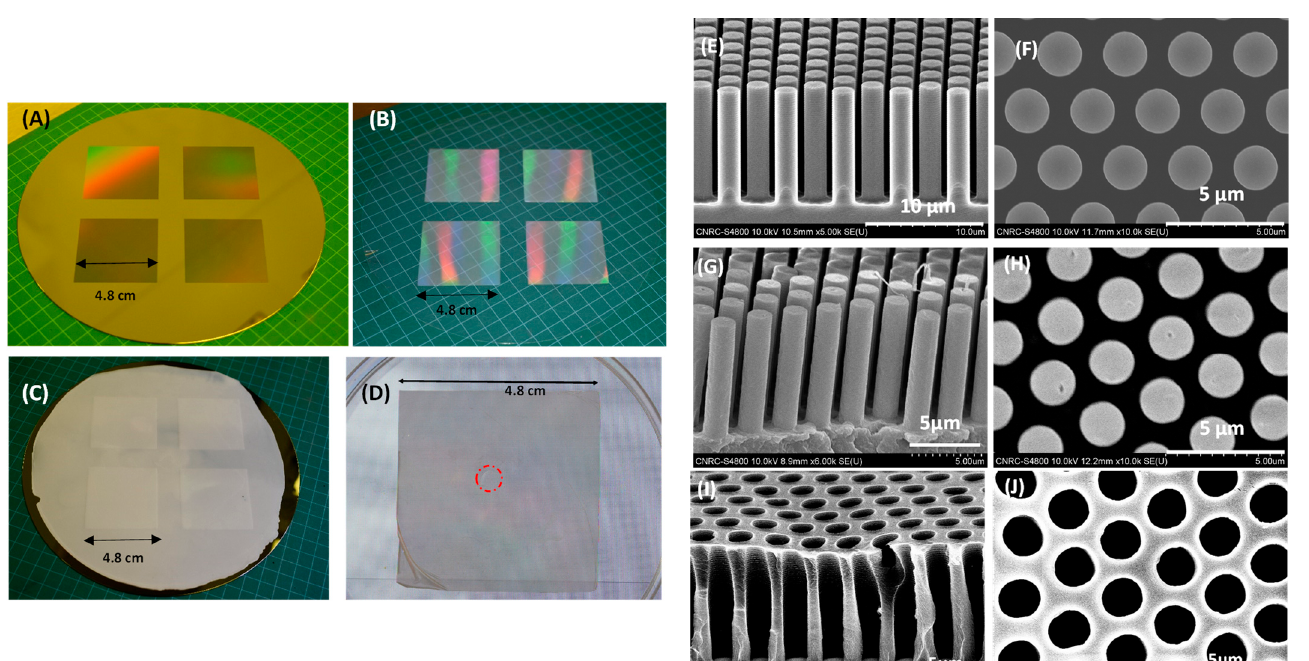
Figure 4. ( A ) Si master mold; ( B ) Intermediate FEP mold replicated from the Si master mold shown in ( A ); ( C ) Photo of a PLA template mold replicated from the FEP mold using HE; ( D ) A section of MD700 membrane (4.8 cm by 4.8 cm) area marked by a dotted red circle (defects) where the holes of the MD700 membrane are not open through. ( E ) SEM image of a Si master mold (tilt view); ( F ) SEM image of a Si master mold (top view); ( G ) SEM image of a sample cut from the PLA template mold (tilt view); ( H ) SEM image of a sample cut from the PLA template mold (top view); ( I ) SEM image of a piece of MD700 membrane replicated from the PLA template mold (tilt view); ( J ) SEM image of a piece of WS membrane replicated from the PLA template mold (top view).